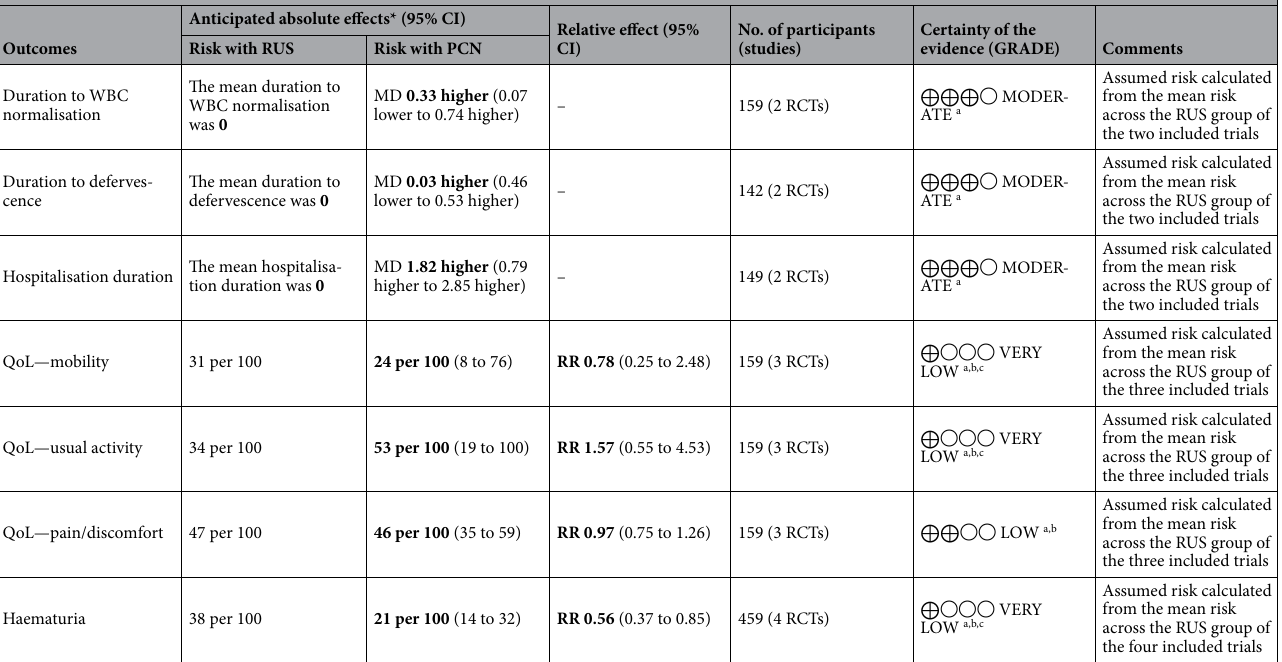
Table 2. Summary of findings for comparison between percutaneous nephrostomy and retrograde ureteral stenting for acute obstructive uropathy. * The risk in the intervention group (and its 95% confidence interval)